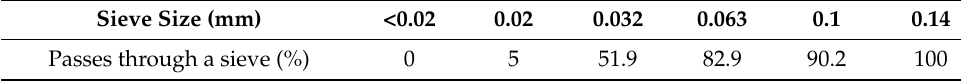
Table 1. Graining curve of the waste material used in the research.